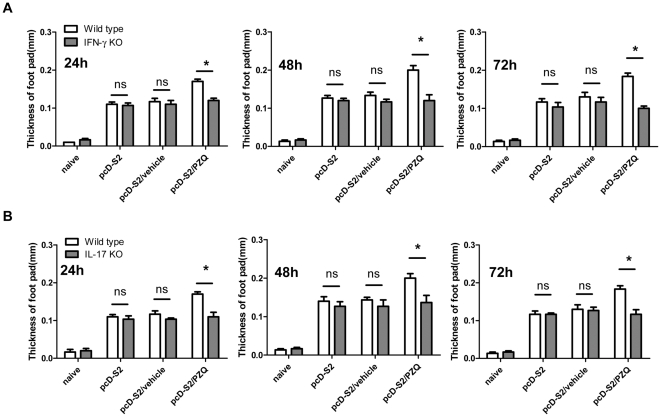
Impairment of DTH in IFN-γ KO mice and IL-17 KO mice immunized with pcD-S2 and PZQ.Mice were challenged with rHBsAg 12 days after the second immunization. DTH was measured at 24, 48 and 72 h. A and B, DTH of IFN-γ and IL-17 KO mice, respectively. Data shown are representative of three independent experiments (* p<0.05; ns, p>0.05).